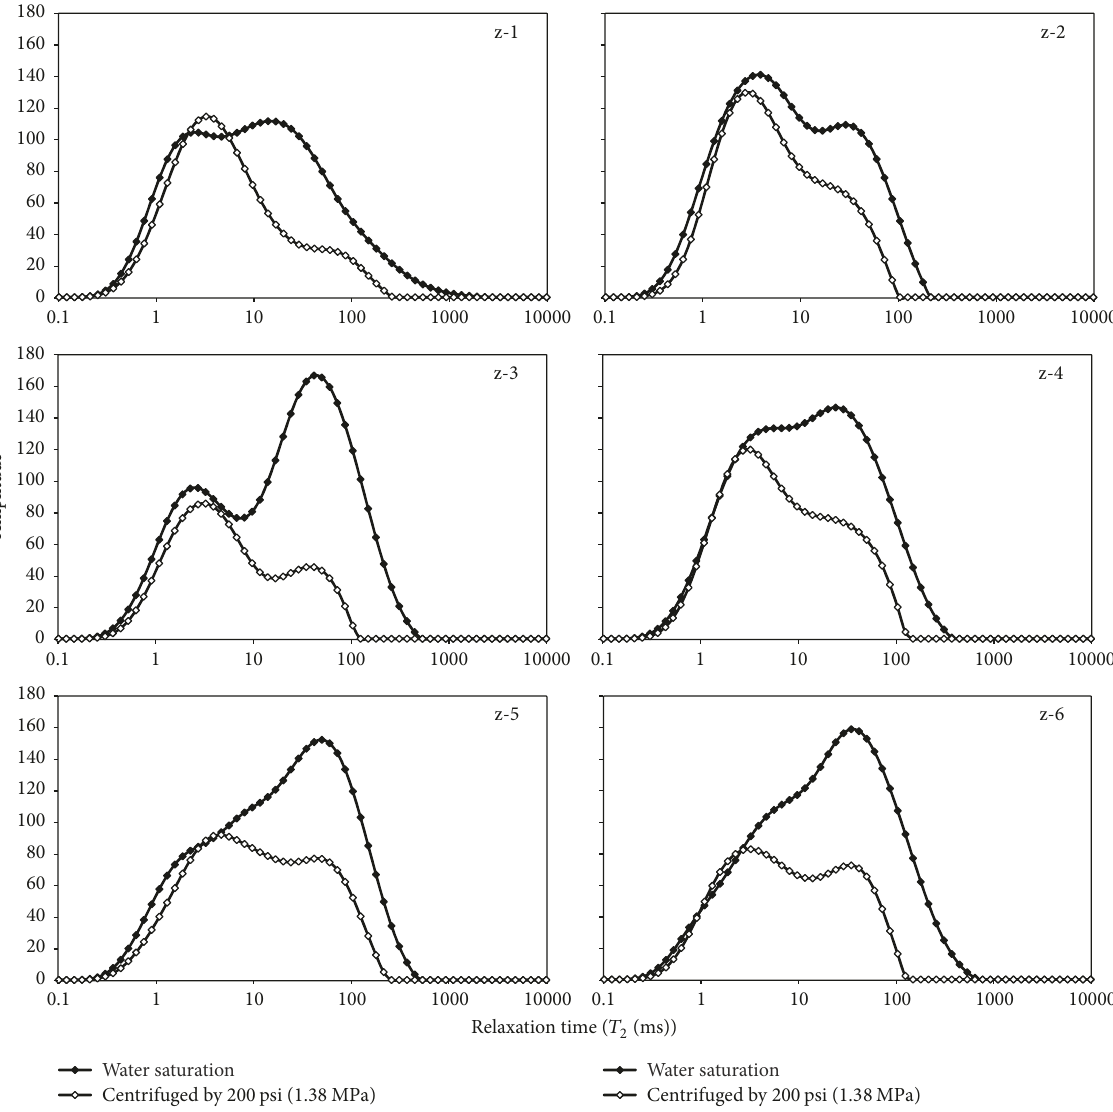
Figure 6: The curve of relaxation time 𝑇 2 and its amplitude result from NMR experiment of the tight clastic rock samples from Upper Triassic Chang 7 Member, Odors